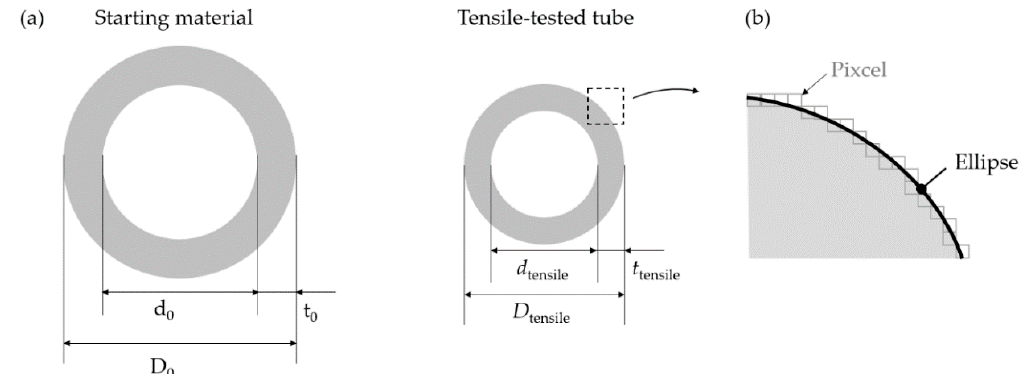
Figure 3. Measurement method of sample dimensions. ( a ) Dimension definition of the tube before and after the tensile test and ( b ) ellipse approximation of the outer circumference pixel.